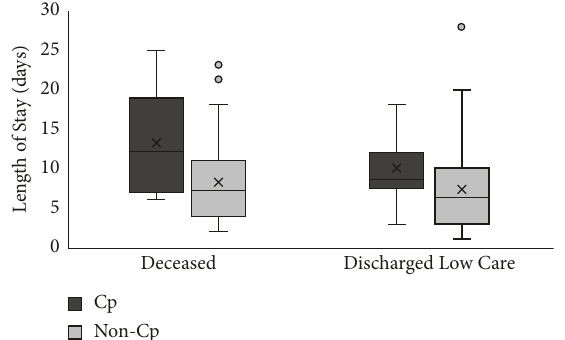
Figure 4: ICU length of stay of both groups was grouped by